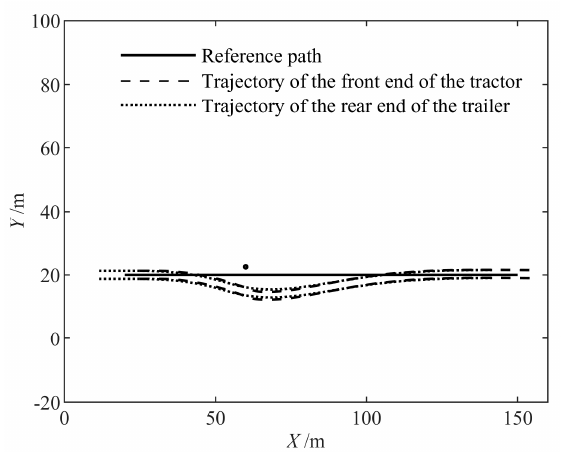
Figure 9. The trajectory of the obstacle avoidance controller based on the circumcircle model in the first group of simulations.